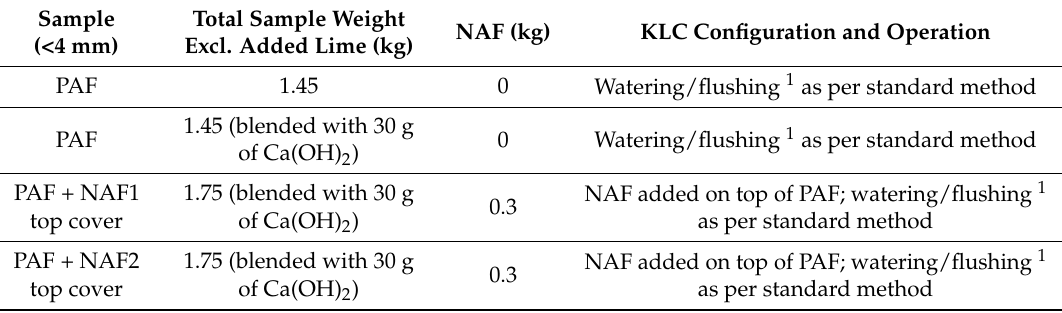
Table 2. The composition of KLC tests using natural mine waste